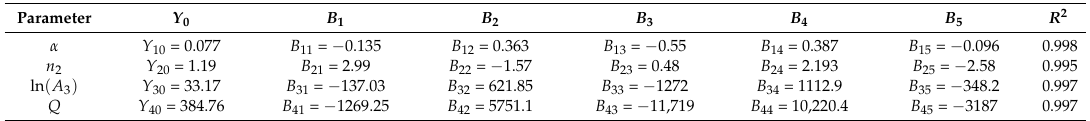
Table 2. The coefficient of the polynomial for α , n 2 , A 3 and Q 3 and the R 2 for this